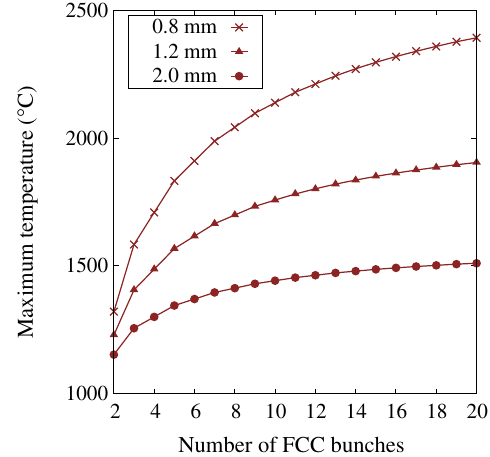
FIG. 6. Maximum temperature in a CfC absorber ( 1 . 4 g = cm 3 ) as a function of the number of FCC bunches swept across the absorber front face. The temperatures were calculated in adiabatic limit, using FLUKA energy deposition results. The transverse bunch size ( σ ) was assumed to be 200 μ m, which corresponds to ffiffiffiffiffiffiffiffiffi p β ≈ 1 km. The different curves assume a different trans- β x y verse bunch separation in the sweep